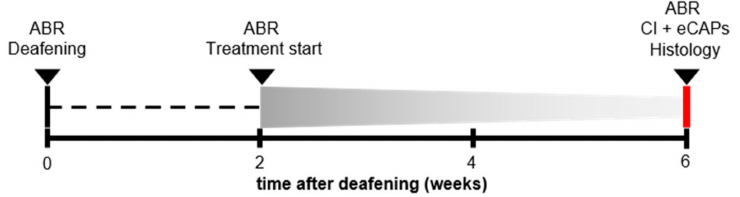
Figure 1. A schematic overview of the experimental procedure. ABR: acoustically evoked auditory brainstem response; CI: cochlear implant; eCAP: electrically evoked compound action